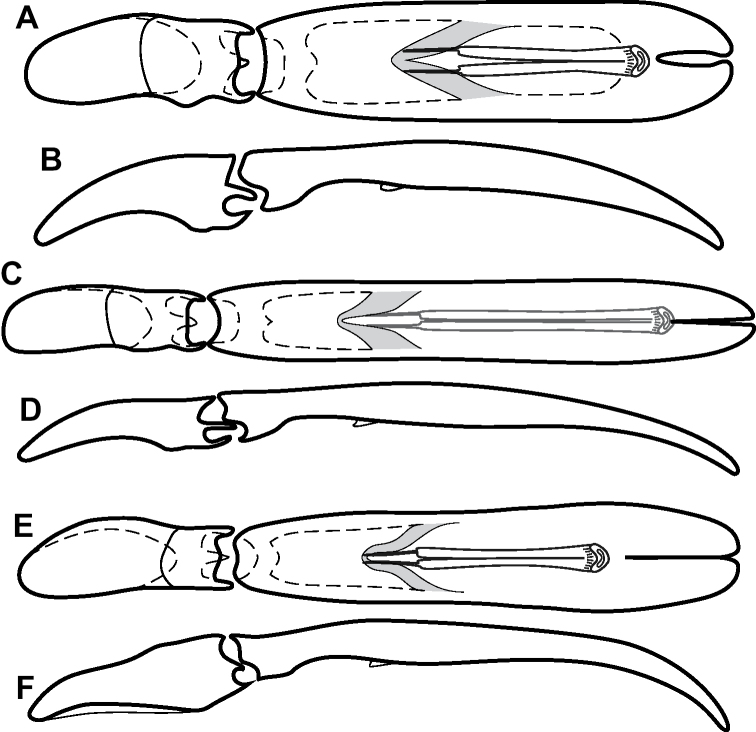
Male genitalia A, BPhelister
sculpturatus: A aedeagus, dorsal B aedeagus, lateral C, DP.
praedatoris: C aedeagus, dorsal D aedeagus, lateral E, FP.
ifficus: E aedeagus, dorsal F aedeagus, lateral.